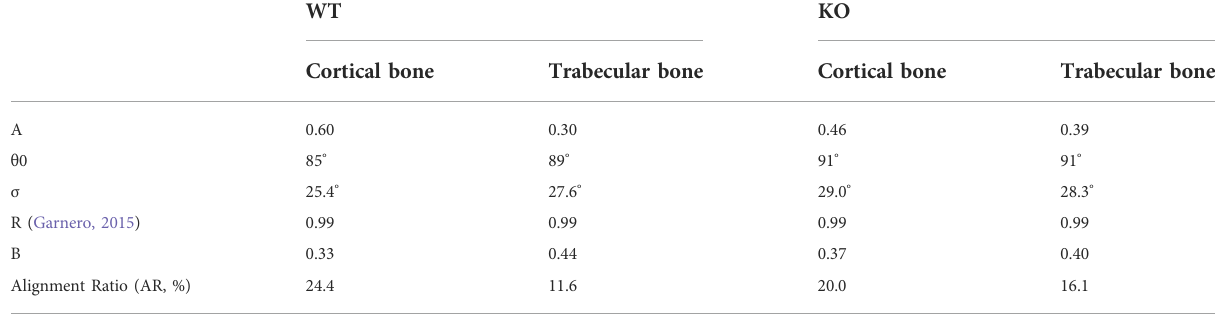
TABLE 2 Optimal parameter values that maximize the R2 of the fi t for data collected with the pump beam parallel-polarized to the craniocaudal axis of the spine. WT KO Cortical bone Trabecular bone Cortical